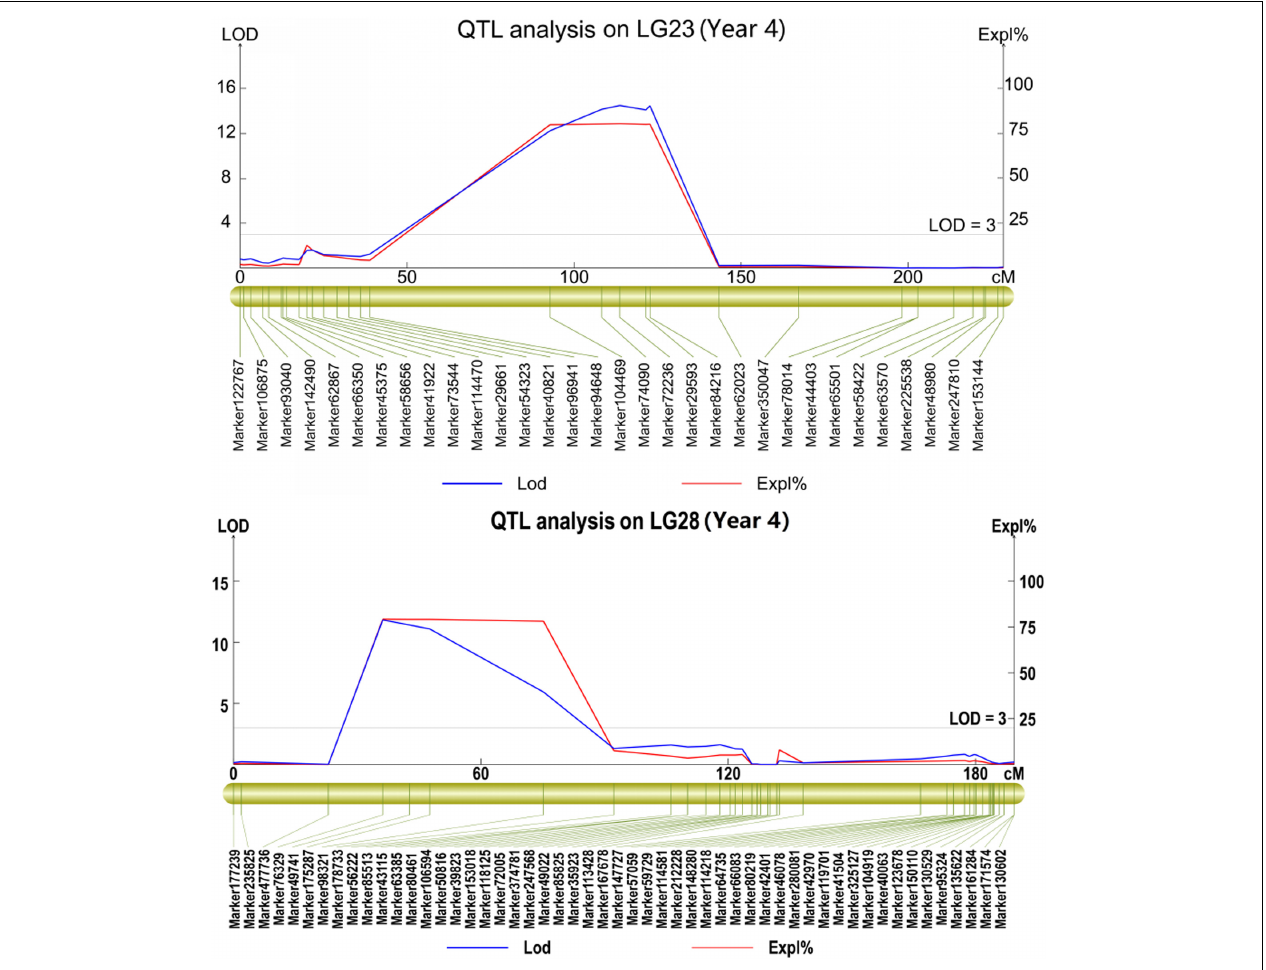
FIGURE 3 | Some repeatable major QTLs associated with smut resistance identified in the mapping population.